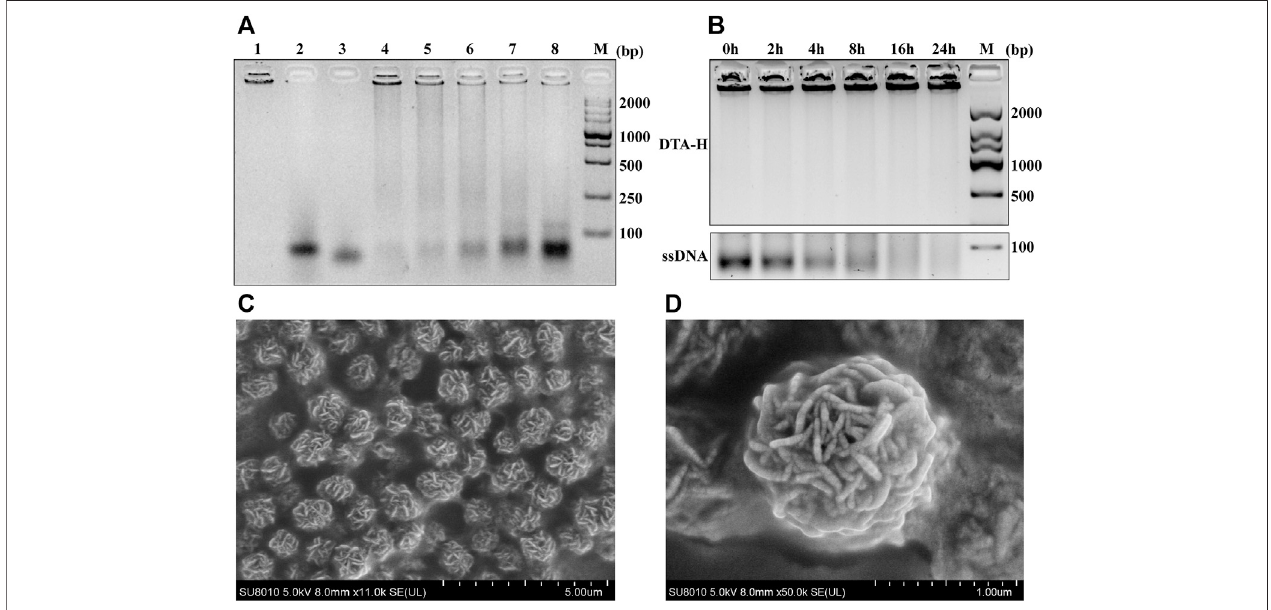
FIGURE 1 | Assembly feasibility of DTA-H and SEM characterization. (A) Optimization of RCA product (P-RCA)/L-type HER2 aptamer (L-HER2)/L-type AS1411 aptamer(L-AS1411)ratio(P-RCA:LHER2:L-AS1411)employedduringassemblyofDTA-H.MrepresentsDNAmarkerswith2,000-bpincrements;Lanes1 – 3represent P-RCA,L-HER2,andL-AS1411;Lanes4 – 8showthatthevolumeratioofL-HER2:L-AS1411:P-RCAisequalto1:1:5,2:2:5,3:3:5,4:4:5,and5:5:5,respectively. (B) Gel electrophoresis (1%) analysis of serum stability of DTA-H. (C, D) are SEM images of DTA-H hydrogel. Scale bar: 5 and 1 μ m.